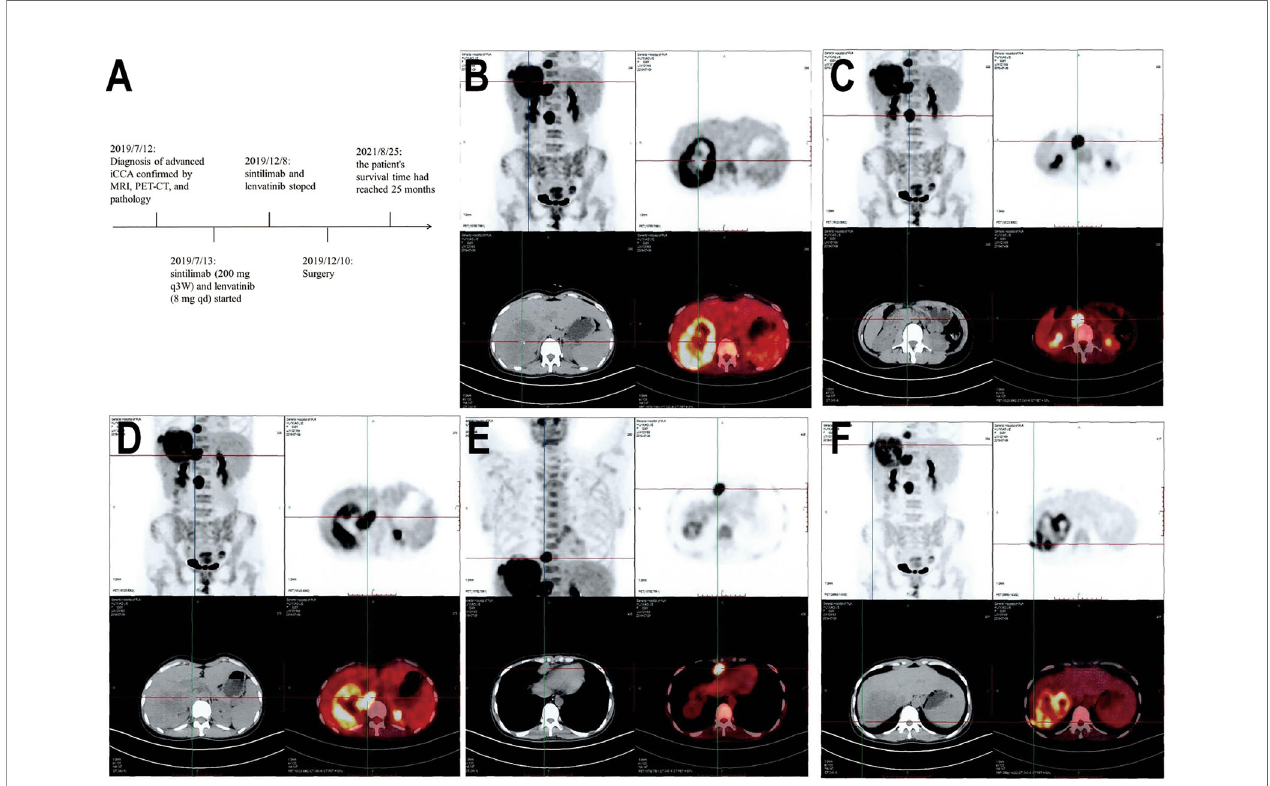
FIGURE 1 | Timeline and PET-CT examination. (A) Indicates initial diagnosis, medication treatment, surgery, and follow-up timeline of the patient. (B) Shows a large mass in the right lobe of the liver with increased radioactive uptake of the solid component. (C) Shows multiple enlarged lymph nodes adjacent to the abdominal aorta with increased radioactive uptake. (D) Shows increased nodular radioactive uptake in the inferior vena cava. (E, F) Show anterior costal diaphragm nodule and right diaphragmatic nodule with increased radioactive